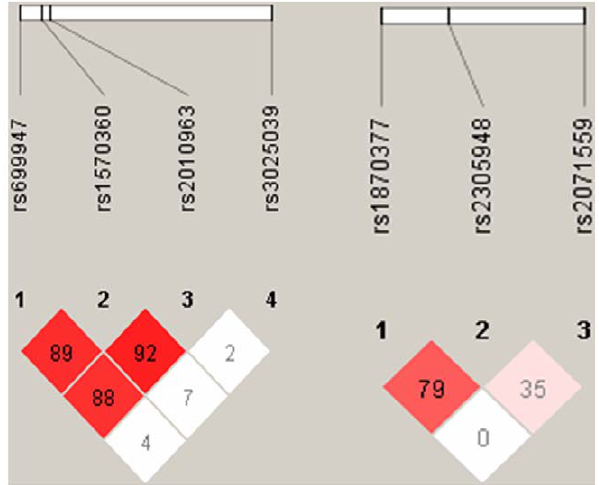
Figure 1. Linkage disequilibrium(LD) of VEGF and KDR polymorphisms. There was strong LD between 2 1154G . A (rs 1570460) and 2 634G . C (rs2010963) (D 9 =0.92), 2 2578C . A (rs 699947)and 1154G . A (rs1570360) (D 9 =0.89). There was strong LD between 1719T . A(rs1870377) and 1192G . A (rs2305948) (D 9 =0.79). doi:10.1371/journal.pone.0047158.g001 PLOS ONE |